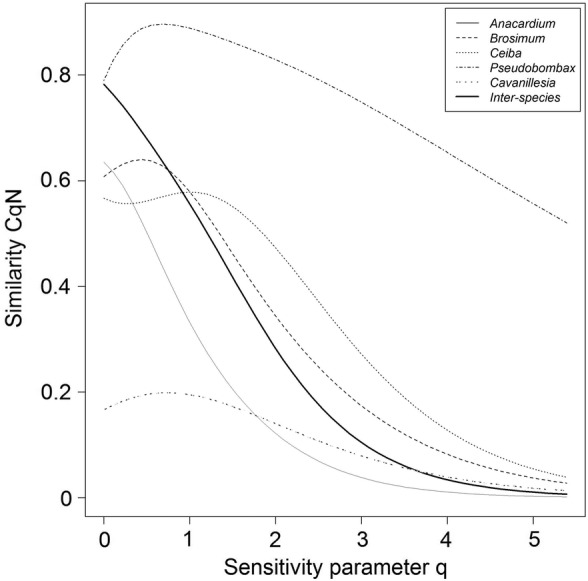
The multiple-assemblage similarity profile CqN (for q = 0–5) of epiphyte assemblages in the tree crowns of A. excelsum (5 trees/60 epiphyte species), B. alicastrum (4/43), C. pentandra (5/47), P. septenatum (5/7), C. platanifolia (4/7) and of epiphyte assemblages in tree crowns between all trees (23/79).